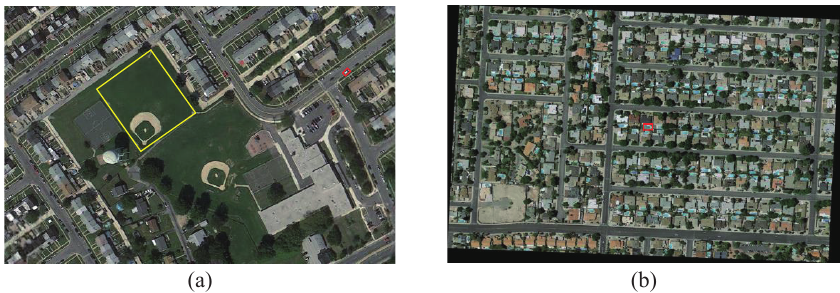
Figure 1. Two remote sensing images in DOTA dataset. ( a ) The yellow rectangle is the bounding box of the baseball diamond and the red rectangle is the bounding box of the small vehicle. There is a big difference in the scale between the two. ( b ) The red rectangle is the ding box of the swimming pool, from which it can be seen that the sparse swimming pools is surrounded by complex